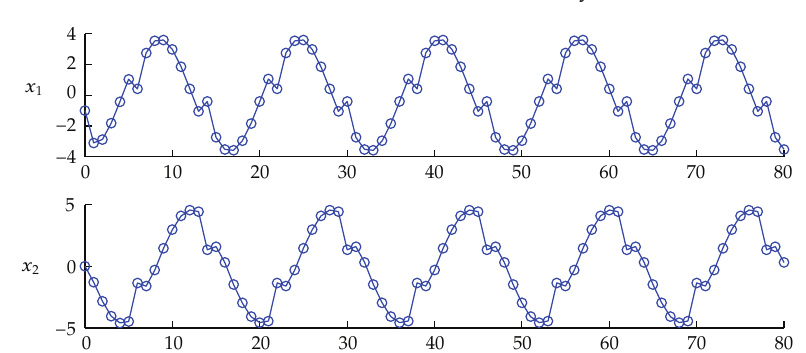
Figure 1: State responses of the discrete-time neural networks with initial conditions (cid:2) x 1 (cid:2) s (cid:3) ,x 2 (cid:2) s (cid:3)(cid:3) T (cid:8) (cid:2) − 1 , 0 (cid:3) T , s ∈ N (cid:5) − 4 , 0 (cid:6)